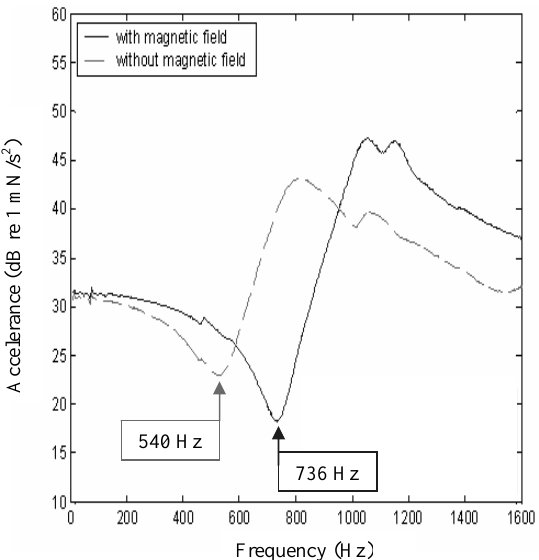
Fig. 13. A tunable fluid-filled beam ATVA.